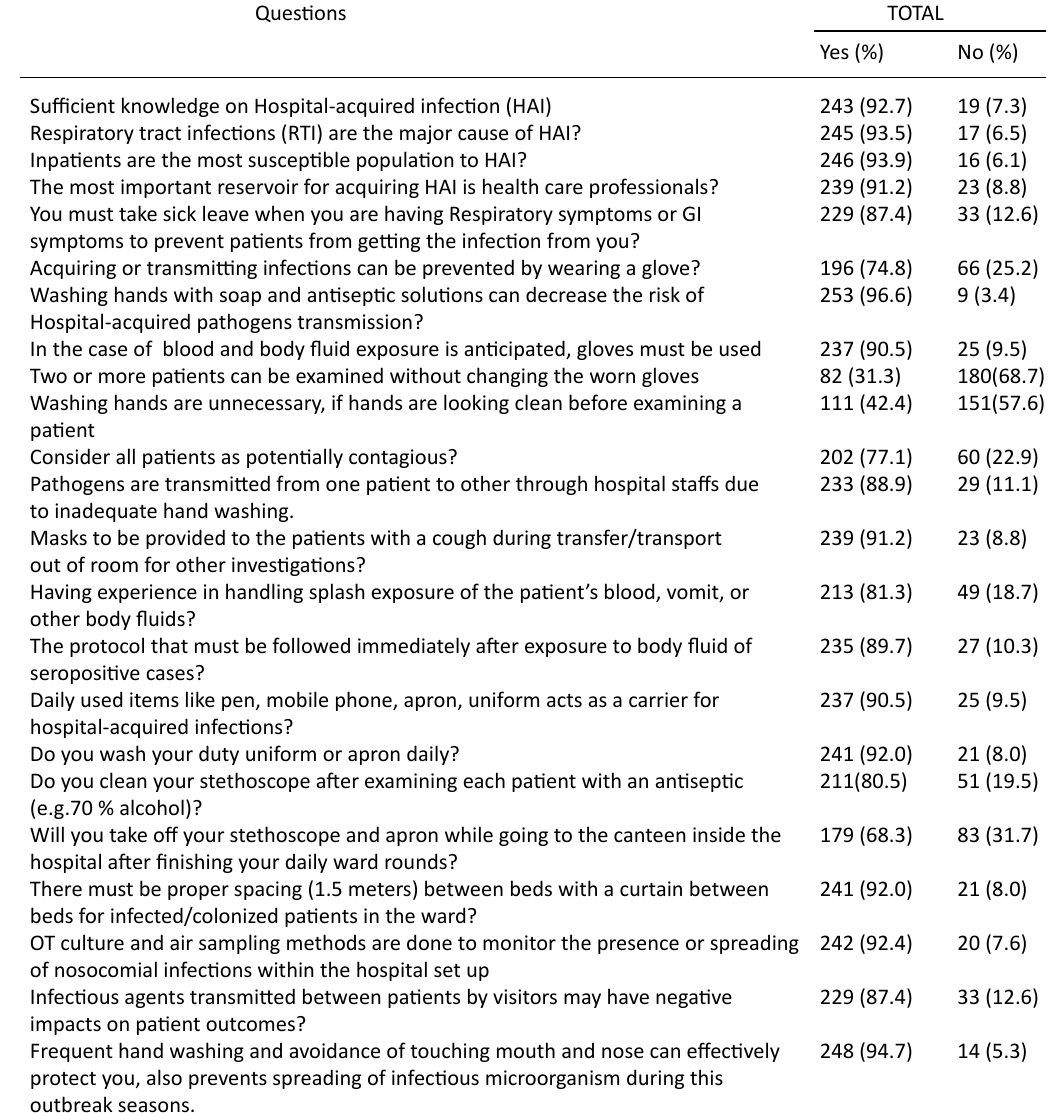
Table 2. Health care professional’s knowledge regarding the prevention of Hospital-Acquired Infections